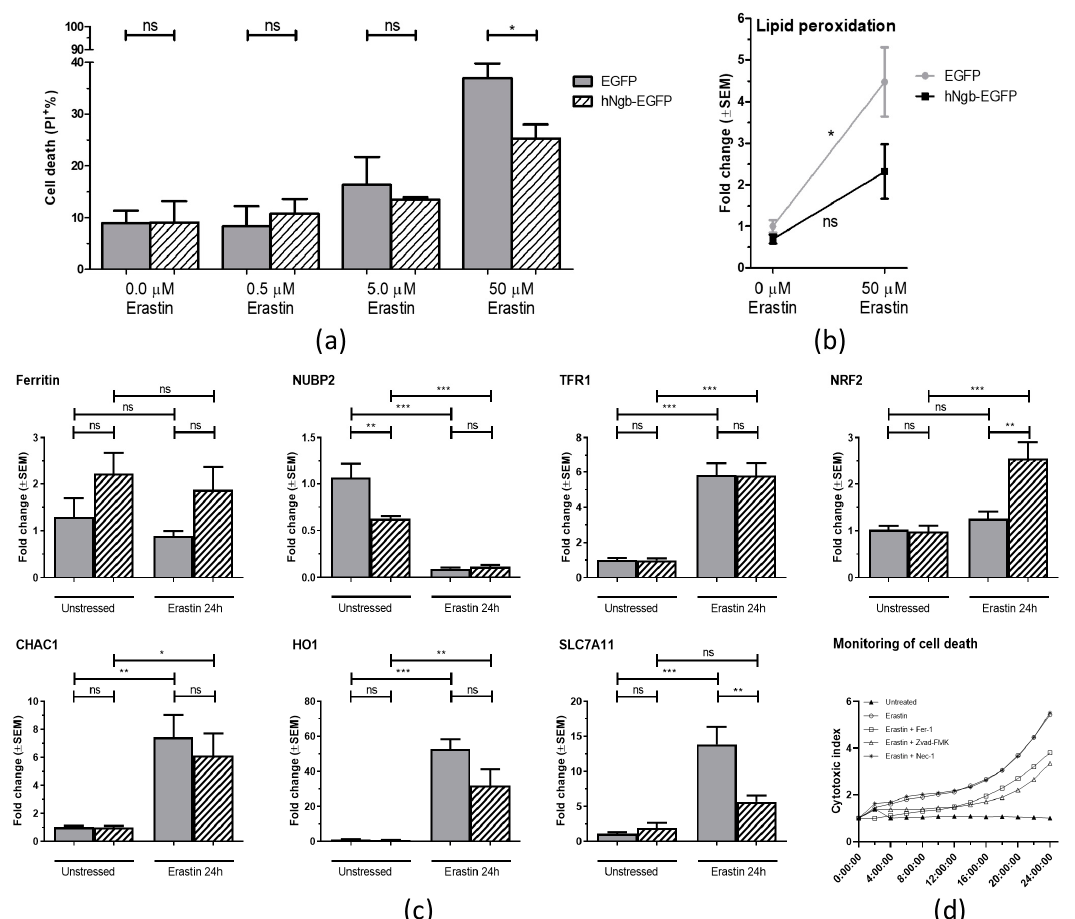
Figure 2. Anti ‐ ferroptotic characteristics of hNgb. ( a/b ) EGFP control and hNgb ‐ EGFP SH ‐ SY5Y